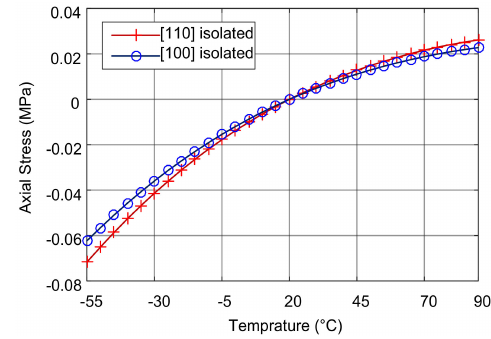
Figure 9. Axial stress of 1-stage isolated DETF (Simulation).